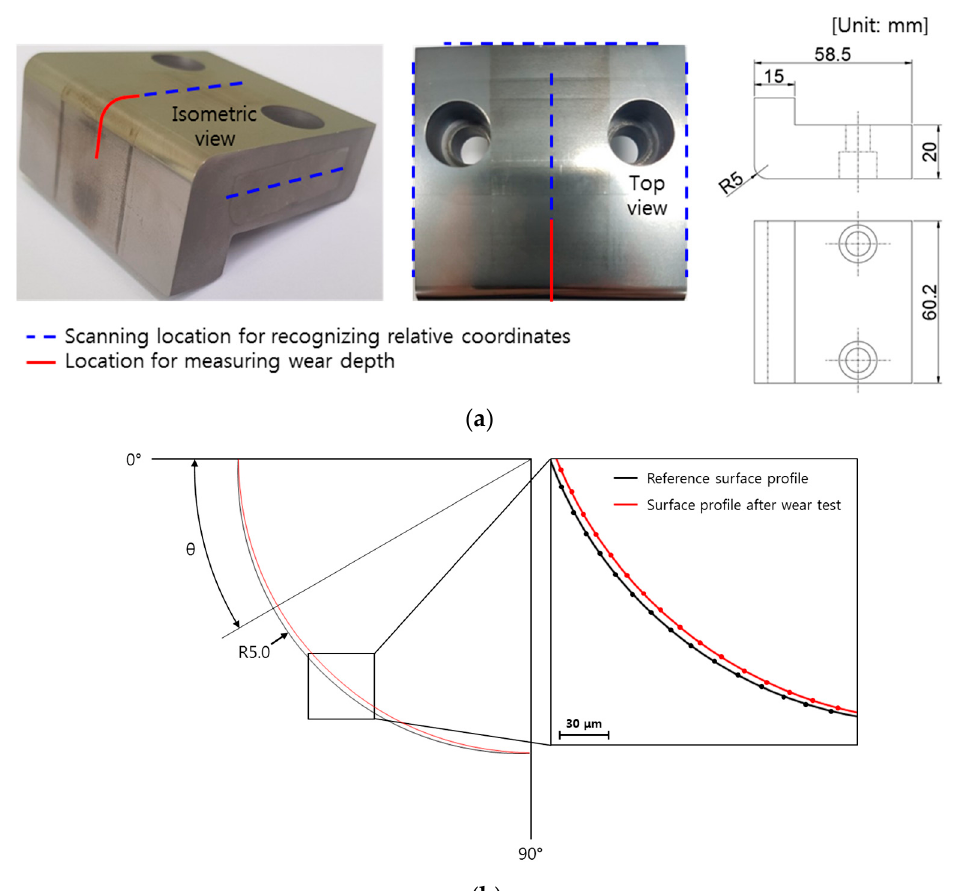
Figure 16. Measuring method of the tool wear depth on the die radius: ( a ) scanning location and ( b ) surface profile.